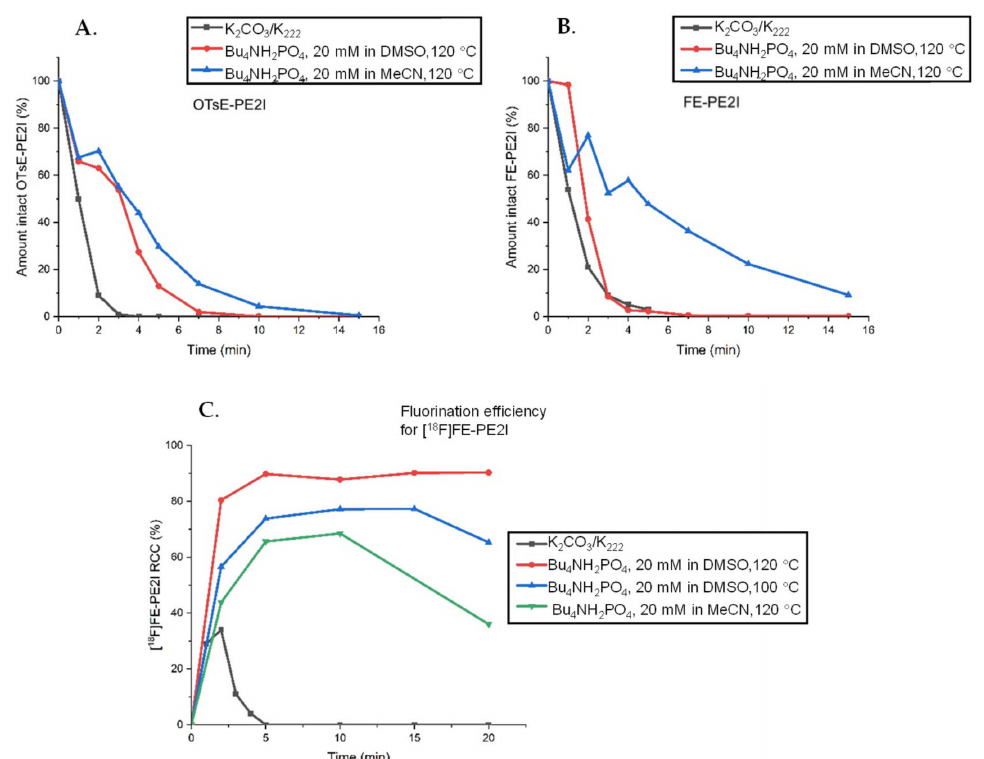
Figure 6. ( A ) Stability of the tosylate precursor OTsE-PE2I in the DMSO or MeCN solution at 120 ◦ C added to the dried QMA eluate eluted by Bu 4 NH 2 PO 4 (K 2 CO 3 /K 222 in DMSO added for comparison). ( B ) Stability of the reference FE-PE2I in the DMSO or MeCN solution at 120 ◦ C added to the dried QMA eluate eluted by Bu 4 NH 2 PO 4 (K 2 CO 3 /K 222 in DMSO added for comparison). ( C ) Radiochemical conversion for [ 18 F]FE-PE2I using CO 32 − -preconditioned QMA eluted by 20 mM solution of Bu 4 NH 2 PO 4 in DMSO or